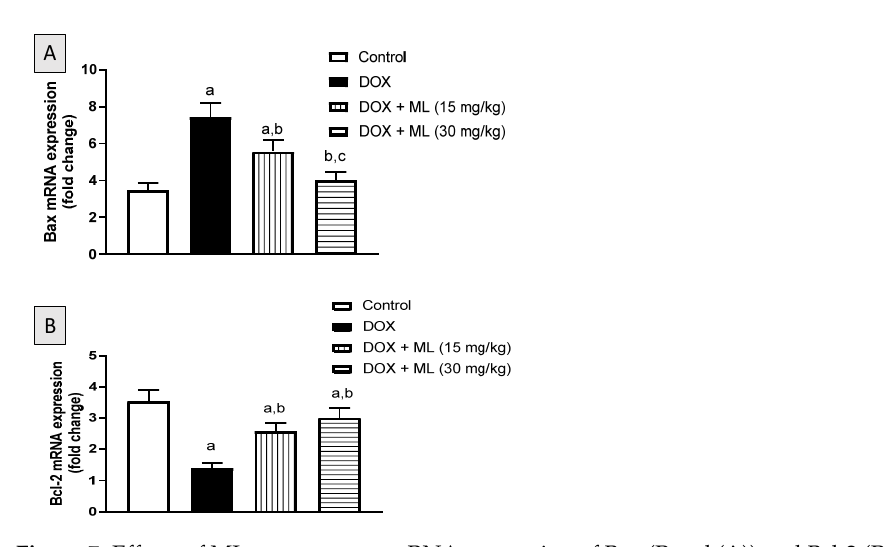
Figure 7. Effects of ML treatment on mRNA expression of Bax (Panel ( A )) and Bcl-2 (Panel ( B )) in the liver tissues. Data presented in bar charts are Mean of optical densities ± SD ( n = 6). a, b or c: Statistically different from Control, DOX or DOX + ML (15 mg/kg), respectively at p < 0.05.